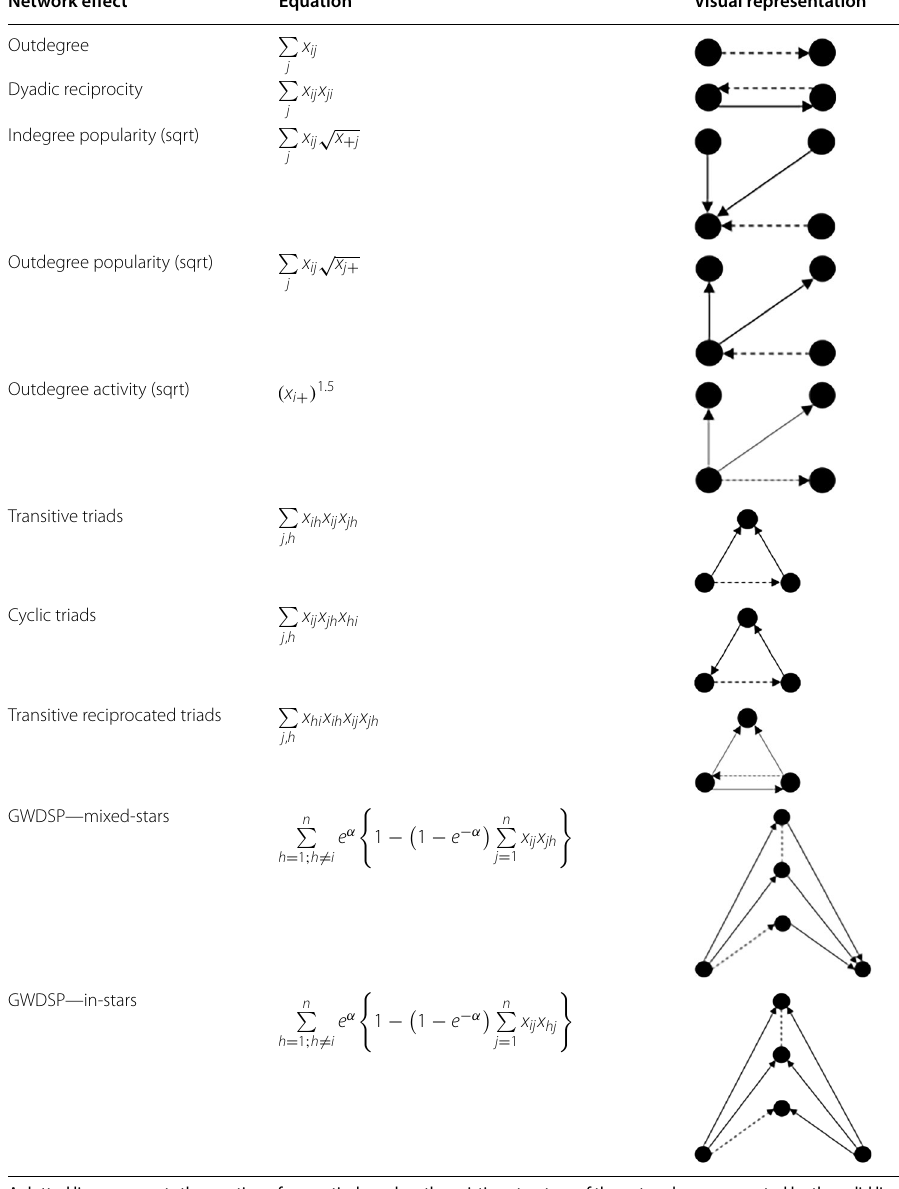
A dotted line represents the creation of a new tie, based on the existing structure of the network as represented by the solid lines i represents Ego, j represents an Alter, and h represents an Alter different from j X ij 1 if the ordered pair i j exists (X ij 0 = → =